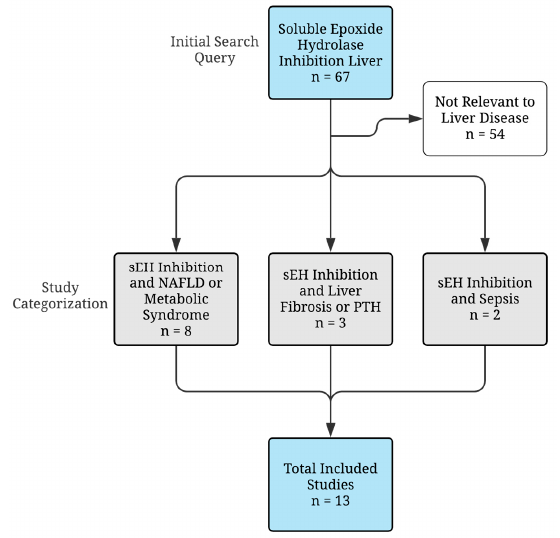
Figure 3. Flowchart describing the literature search strategy, exclusion criteria, and study